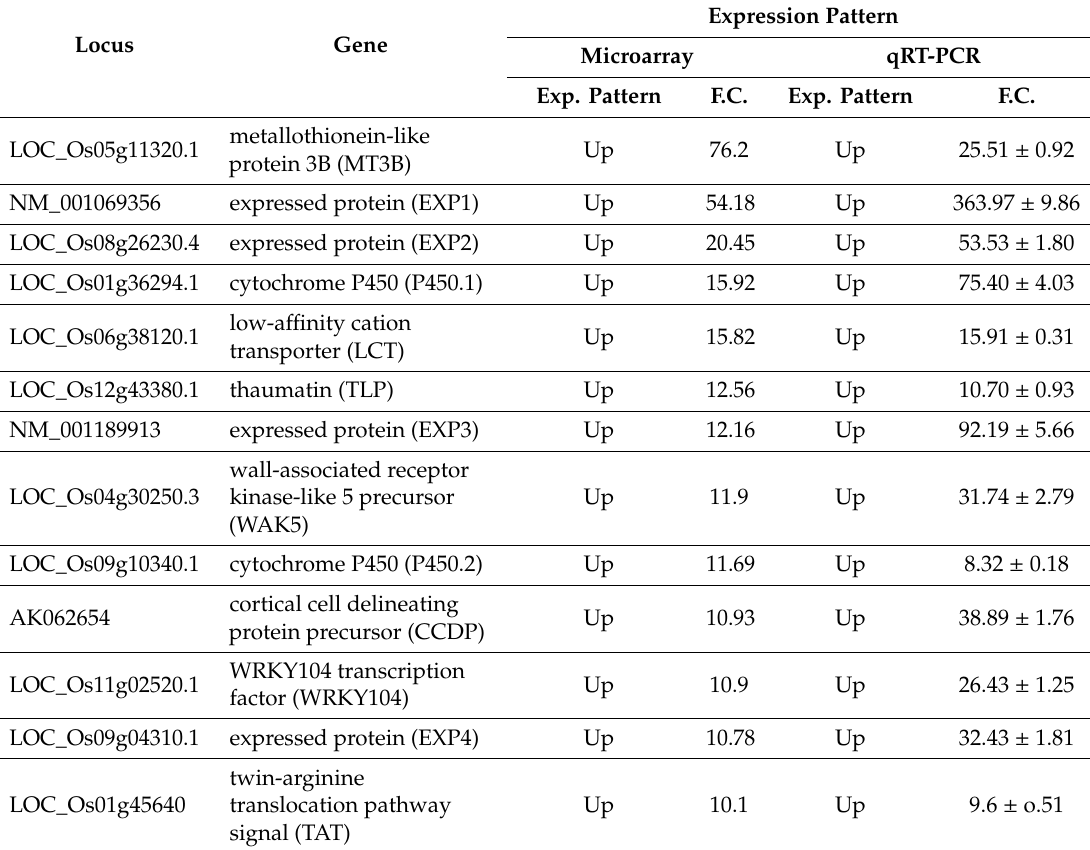
Table 2. Selected DEGs with the highest expression values confirmed through microarray and qRT-PCR